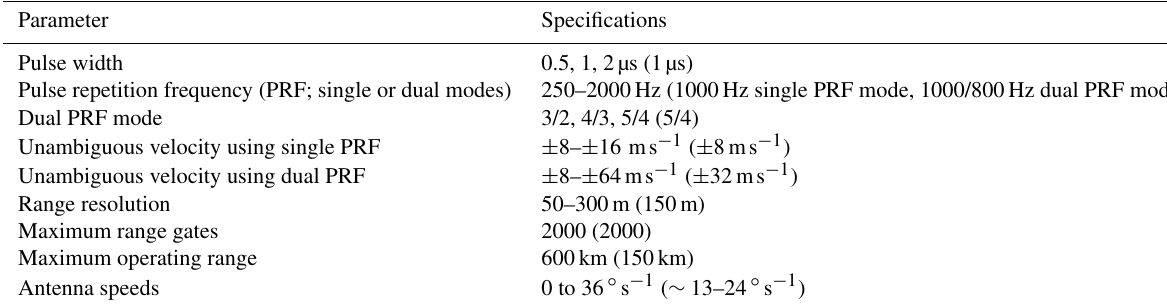
Table 2. Parameter settings. Boldface indicates settings typically used for